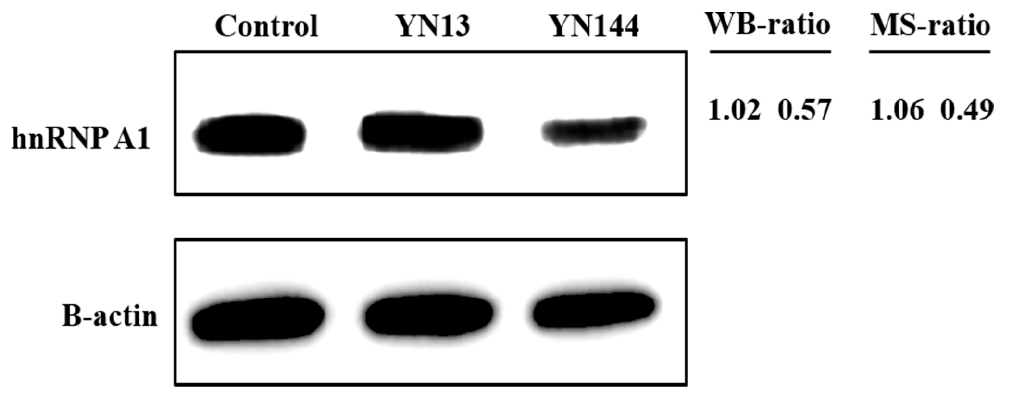
Figure 1. Confirmation of expression of hnRNP A1 by western blot. Analysis of hnRNP A1 expression level in the jejunum tissues of the control, YN13-infected and YN144-infected groups. The WB-ratio (western blotting ratio, PEDV infected/mock) was calculated based on the relative intensity of each band in PEDV-infected group to the corresponding band in control. β -actin was used as a loading control. The MS-ratio (infection/control) obtained by MS analysis are shown on the right.